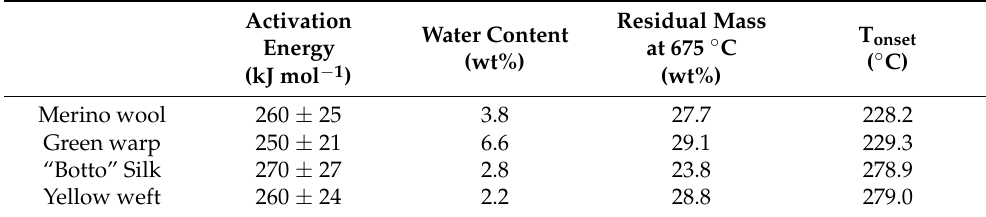
Figure 3. Thermoanalytical curves of Merino wool, “Botto” silk and the Sixteenth Century yarns. Table 3. Activation energy for the degradation process under inert atmosphere of commercial Merlin wool, “Botto” silk and the Sixteenth Century yarns.